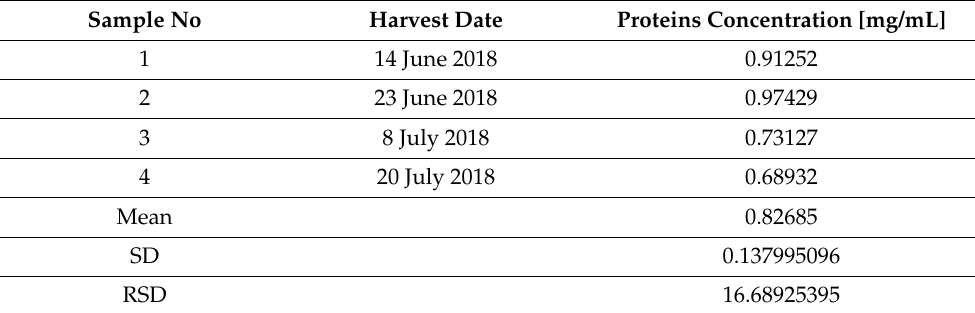
Table 2. Total protein concentration in aqueous solutions of bee pollen harvested in June and July 2018; SD — standard deviation; RSD — relative standard deviation.